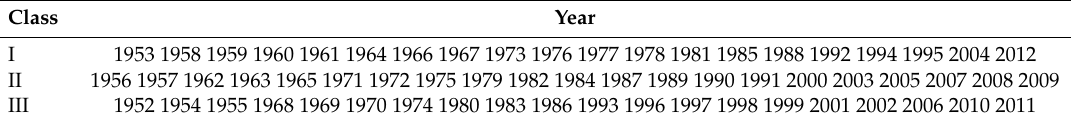
Table 1. Classifications of summer precipitation pattern over eastern China from 1952–2012.